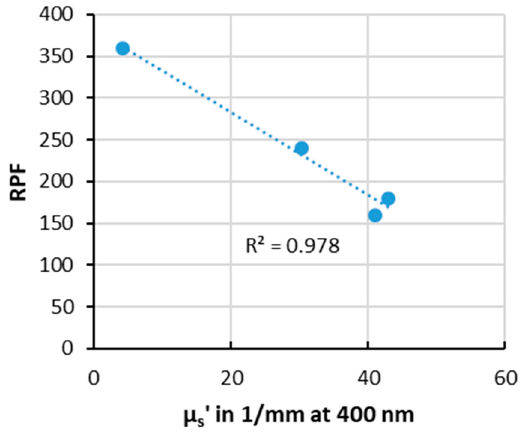
Figure 3. Correlation of RPF with µ s ‘ for scattering coefficients at 400 nm (R 2 = 0.98). 347